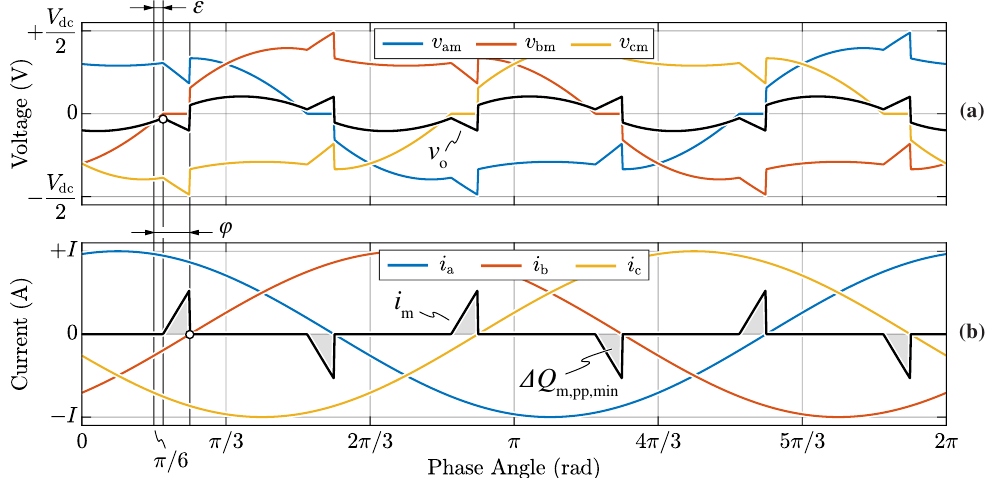
Figure A4. Zero-sequence voltage v o ( a ) and mid-point current local average i m ( b ) for M = 0.8 (region 3 ) and ϕ = 15°. Zero mid-point modulation (ZMPCPWM) is adopted. The most relevant angle definitions for the analytical calculations (i.e., ϕ , ε ) are